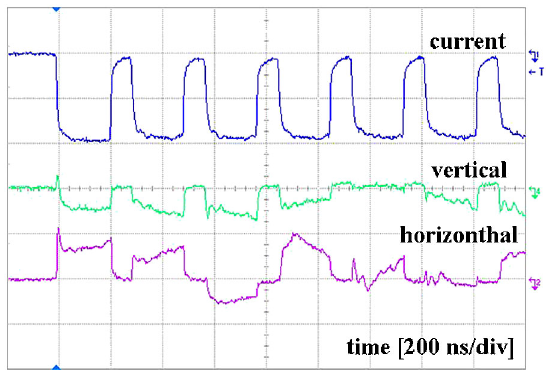
FIG. 20. Scope traces from a ring BPM after the installation of the new RFDs. The plot shows, from top to bottom, the circulat- ing beam current in the case of 400 bunches and the vertical and horizontal signals. The vertical scale for the current signal is (cid:6) 2 A = division , the vertical scale for the vertical and horizontal signal is (cid:6) 2 mm = division